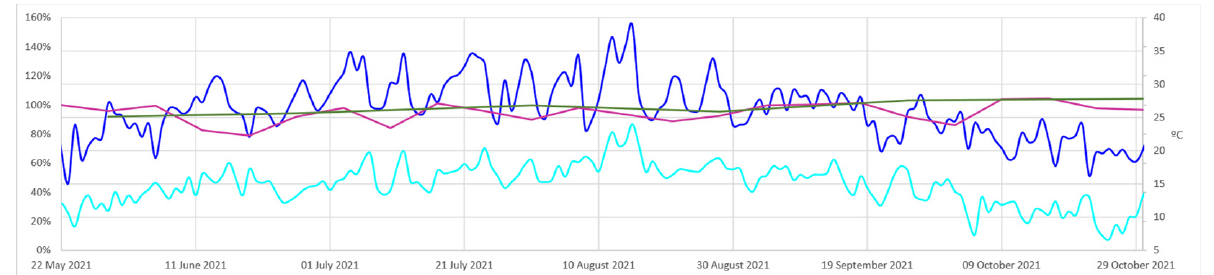
Figure 6. Moisture content (BBMC%, purple line and LFMC%, green line) vs. weekly-accumulated precipitation (blue column) and relative humidity (light brown line) during the 24 weeks study.